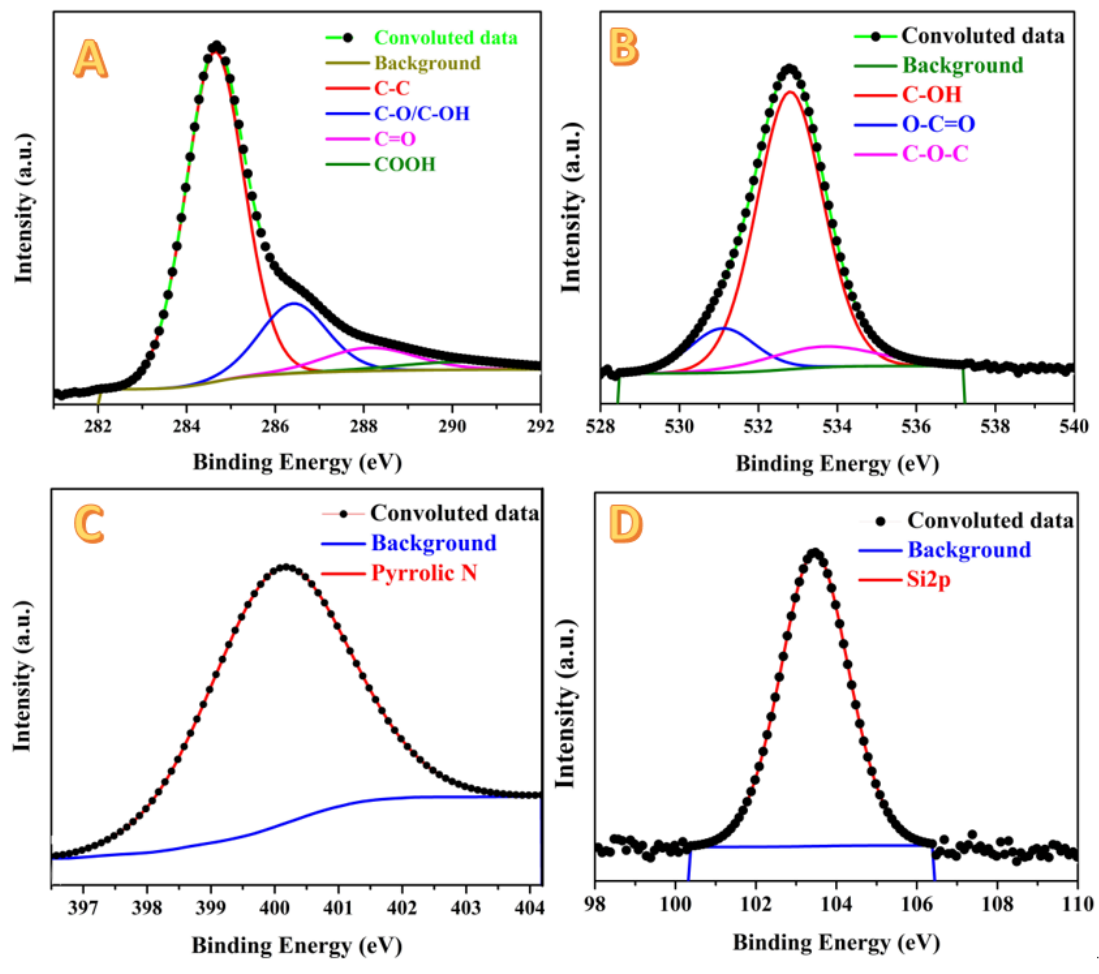
Figure 7. XPS analysis results for H 3 PO 4 /KOH combined agent-activated carbon: C1s; ( A ), O1s; ( B ), N1s; ( C ) and Si2p; ( D ). ( B ), N1s; ( C ) and Si2p; ( D